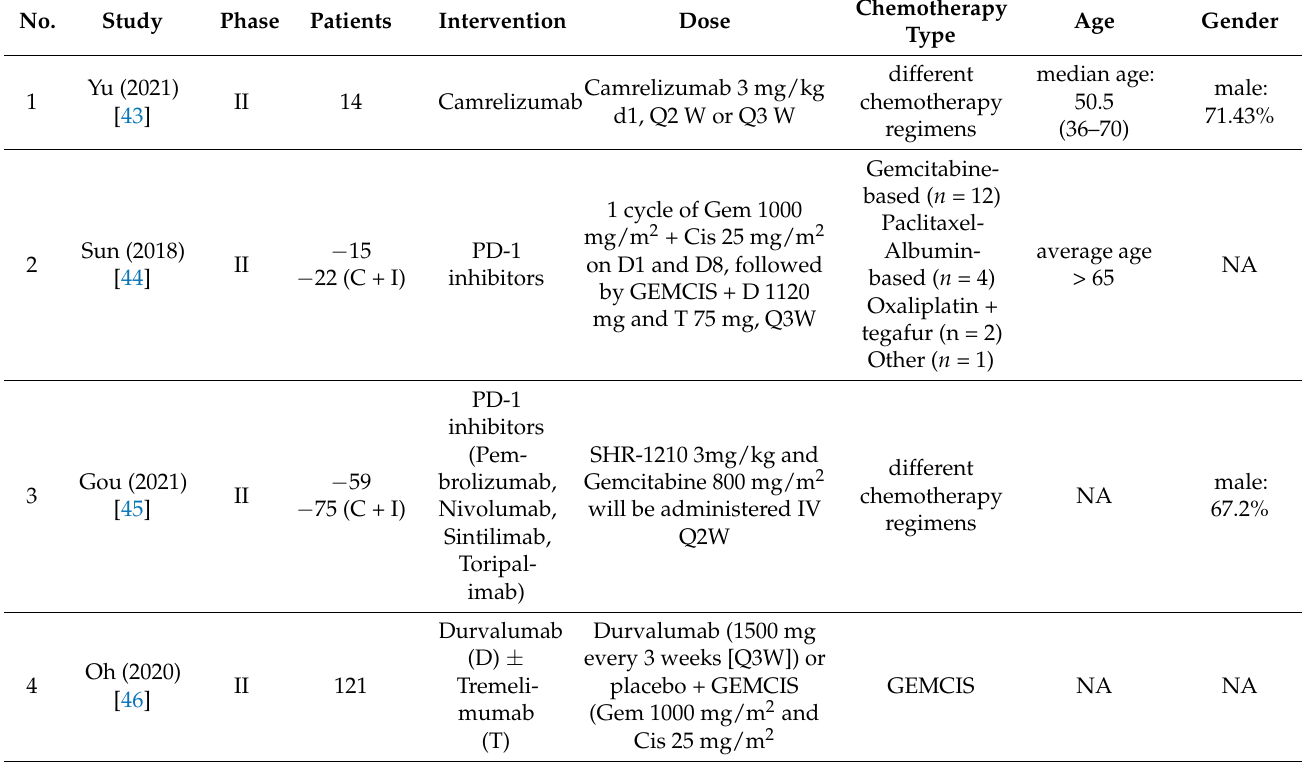
Table 4. Basic characteristics of